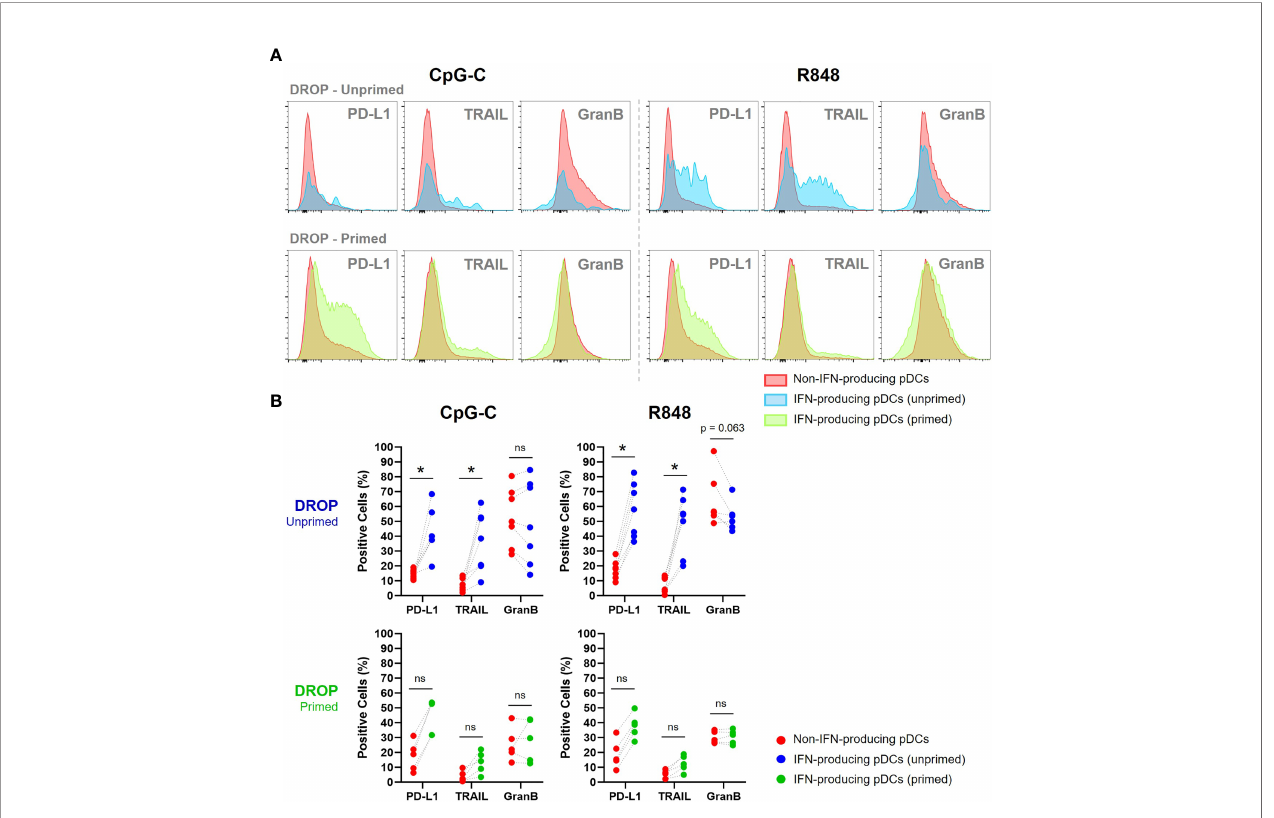
FIGURE 4 | IFN a producing pDCs are phenotypically similar to previously described killer pDCs. (A) Single-encapsulated pDCs were either primed or left unprimed, incubated with IFN a Catch Reagent, activated with 50 m g/mL CpG-C or R848 for 18h and gated for IFN-producing (blue; unprimed, and green; primed) and non- IFN-producing pDCs (red). Histograms represent relative expression levels of PD-L1, TRAIL and granzyme B for merged data of 7 and 5 representative donors for unprimed and primed conditions, respectively. (B) Scatter plots show paired data of non-IFN-producing pDCs, IFN-producing pDCs and their corresponding percentage of positive cells for PD-L1, TRAIL and granzyme B per donor. Wilcoxon signed-rank test. *p < 0.05. ns, non-signi fi